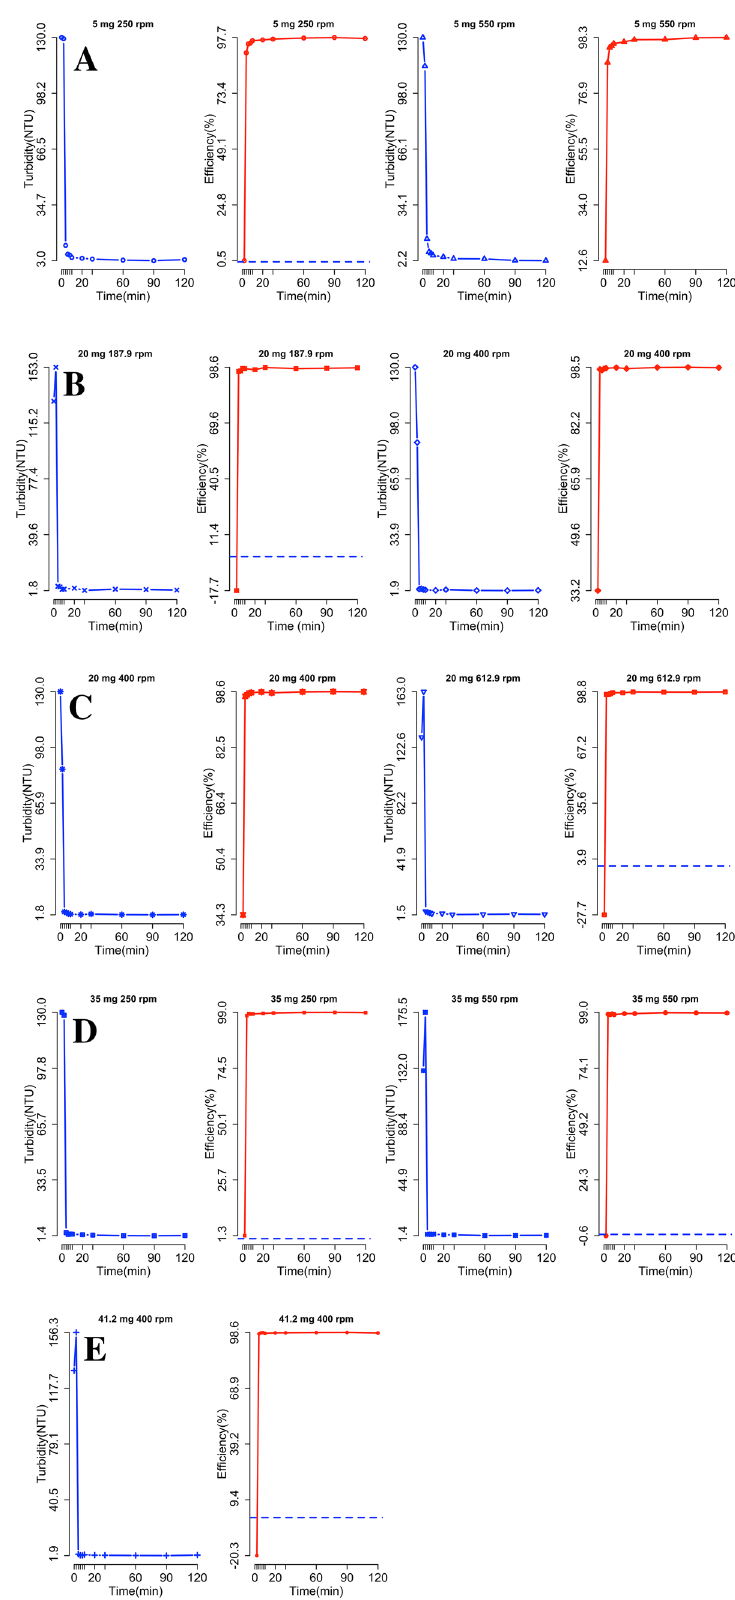
Fig. 2 Turbidity × Time (blue) and Efficiency × Time (red) for 5 mg L −1 (250 RPM), 5 mg L −1 (550 RPM), 20 mg L −1 (187.9 RPM), 20 mg L −1 (400 RPM), 20 mg L −1 (2) (400 RPM), 20 mg L −1 (612.9 RPM), 35 mg L −1 (250 RPM), 35 mg L −1 (550 RPM), 41.2 mg L −1 (400 RPM). The blue dashed line means the zero for y-axis when the initial efficiencies are lower or close to